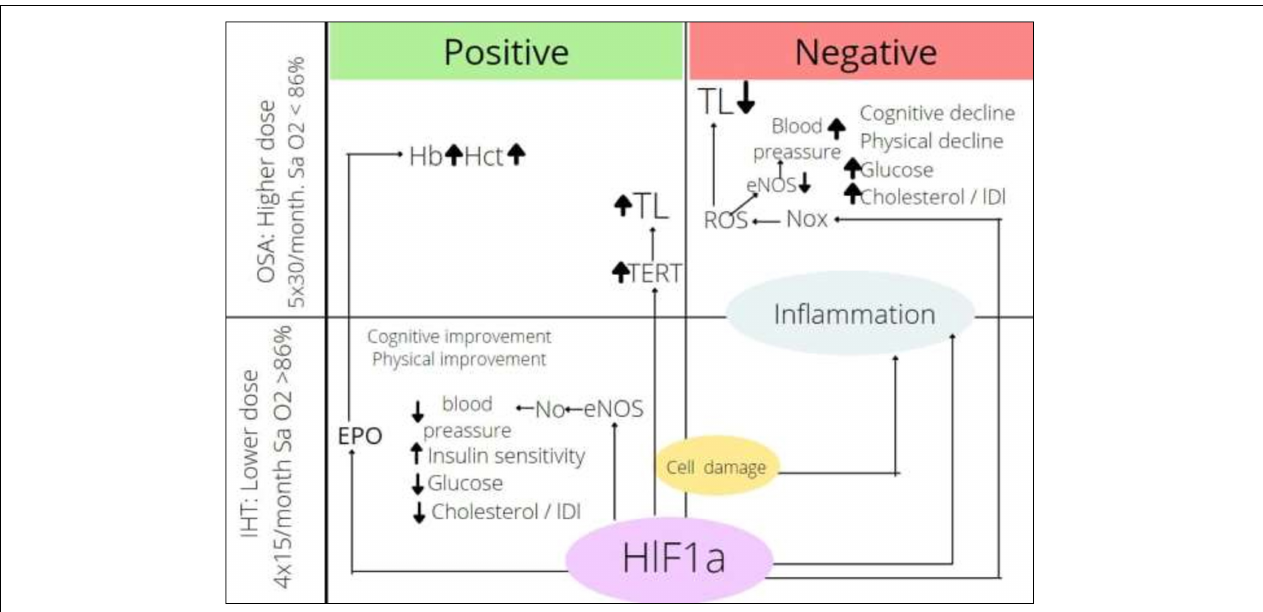
FIGURE 2 | Effects of intermittent hypoxia depending on dose. HIF-1 α , hypoxia inducible factor-1 α ; ROS, reactive oxygen species; Nox, nicotinamide adenine dinucleotide phosphate oxidase; eNOS, endothelial nitric oxide synthase; TERT, telomerase reverse transcriptase; TL, telomere length; EPO, erythropoietin; Hb, hemoglobin content; Hct, hematocrit; IHT, intermittent hypoxic training; OSA, obstructive sleep